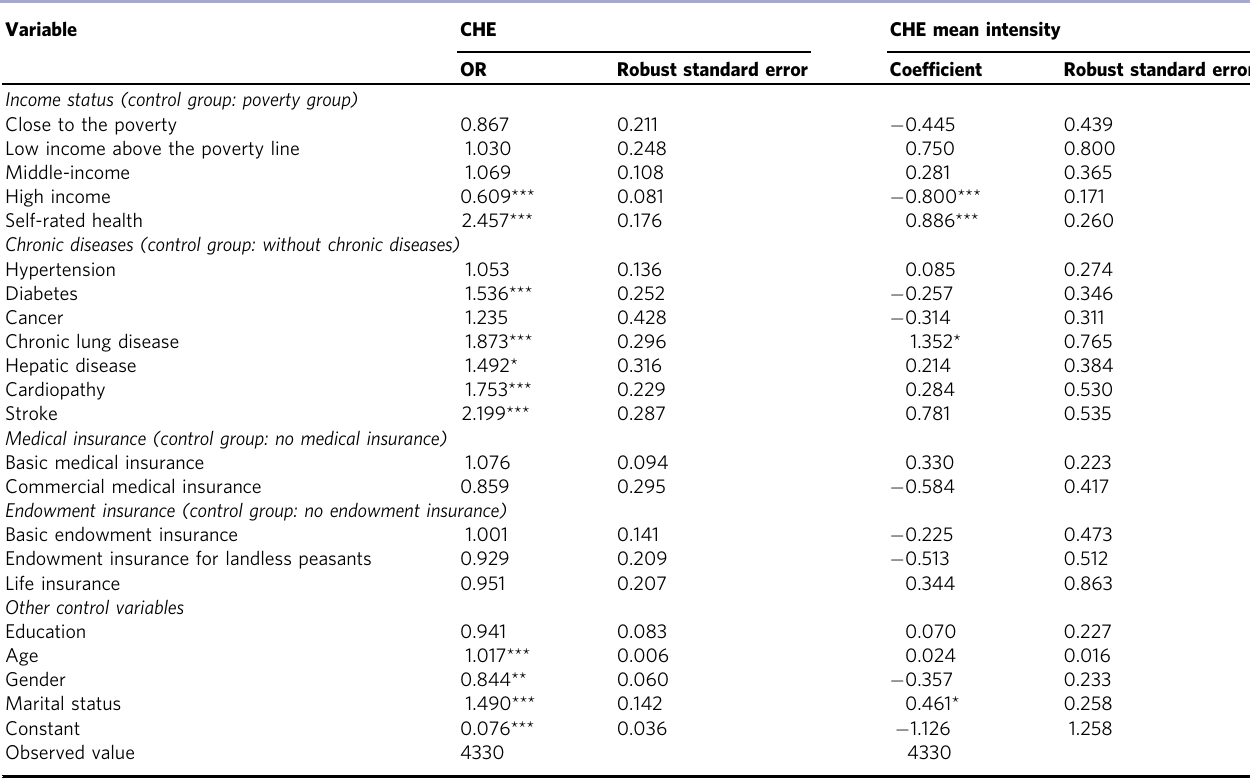
Table 7 Robustness tests for CHE after narrow down the sample age range.